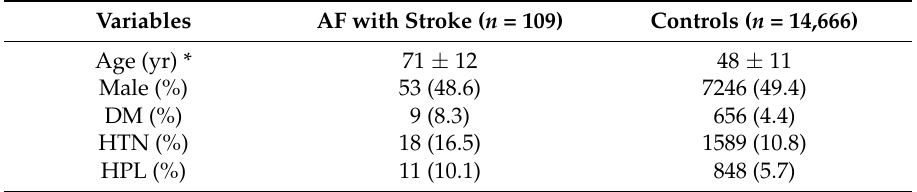
Table 1. Clinical